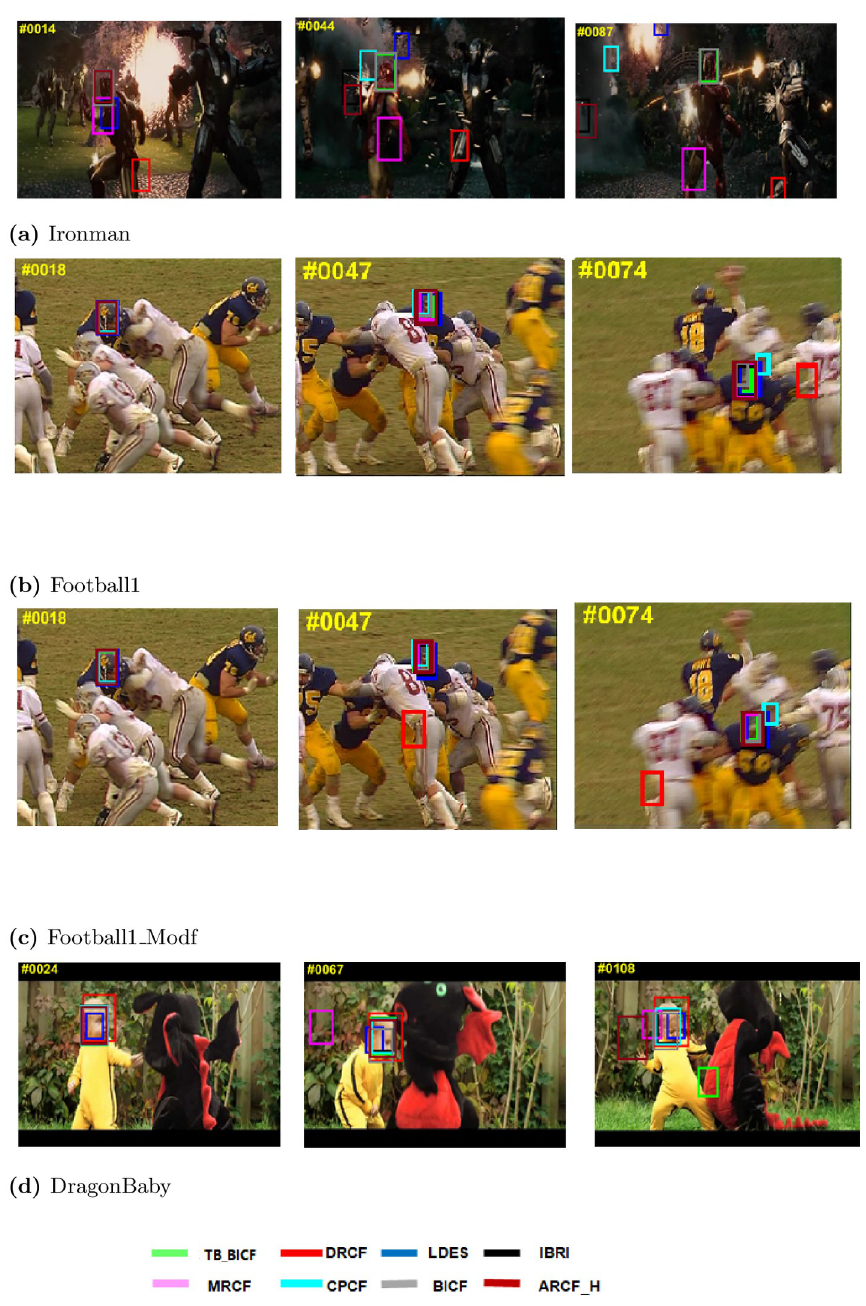
Fig 6. Qualitative assessment of the tested trackers on the a) Ironman, b) Football1, c) Football1_Modf and d) DragonBaby video sequences